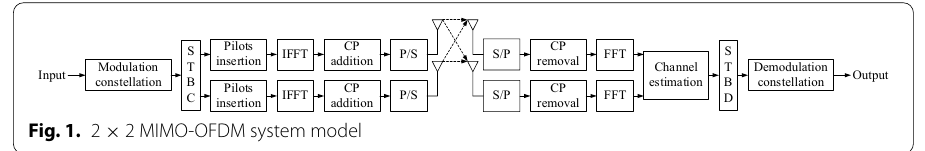
Fig. 1. 2 2 MIMO-OFDM system ×